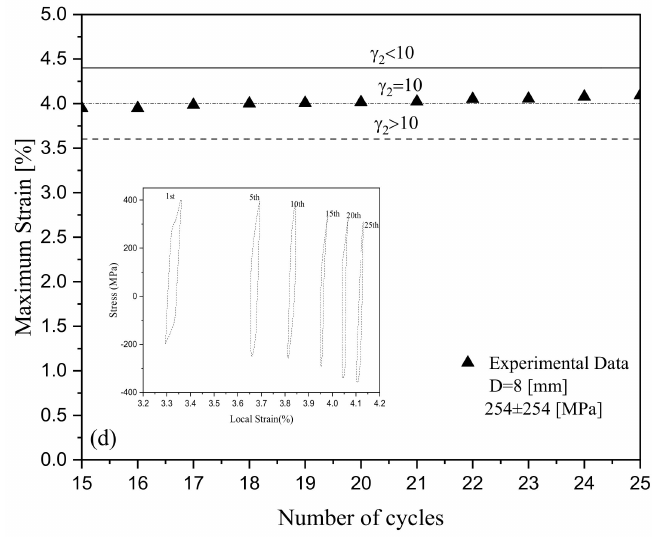
Figure 3. Determination of coefficients C, γ 1 , and γ 2 to achieve consistency condition based on the A-V model. ( a – c ) several trials of coefficients C , γ 1 , and γ 2 to achieve a consistency condition, and ( d ) measured and predicted maximum strain values at the notch root versus loading